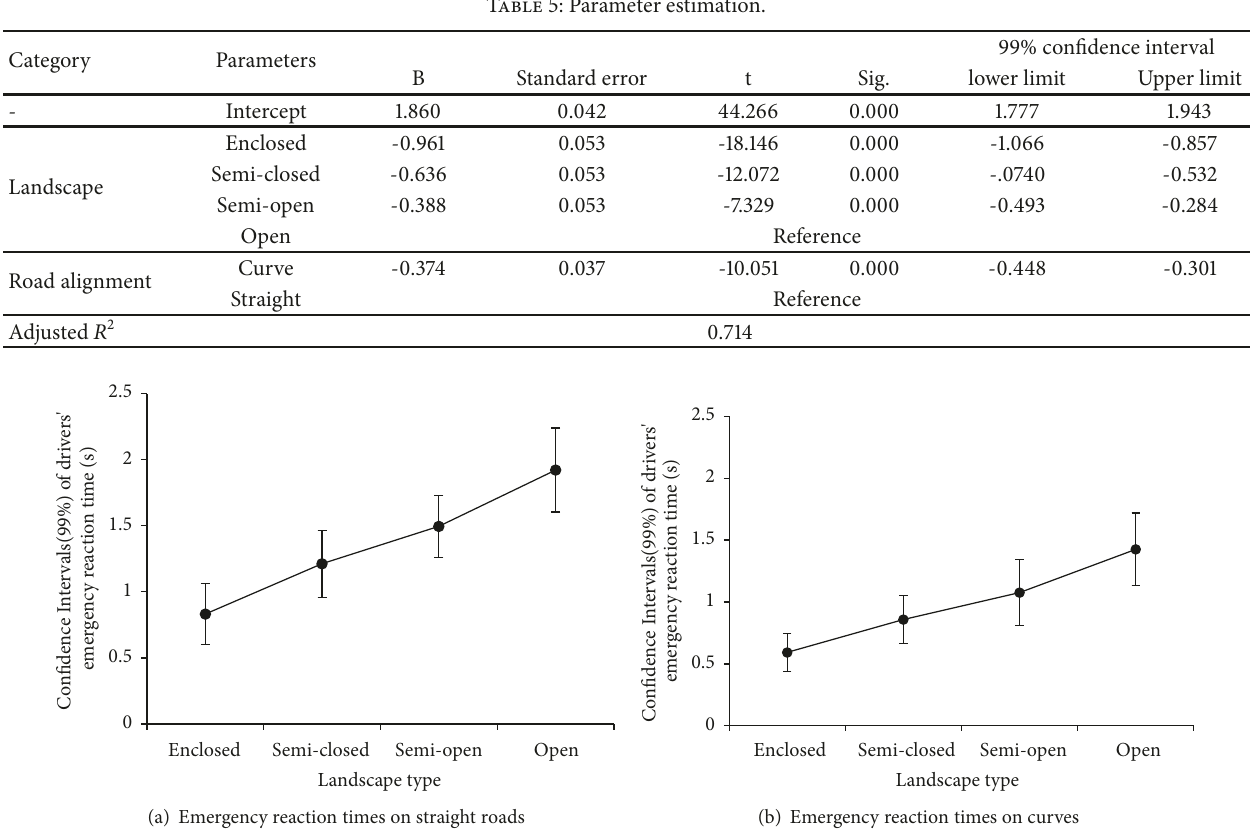
Table 5: Parameter estimation.